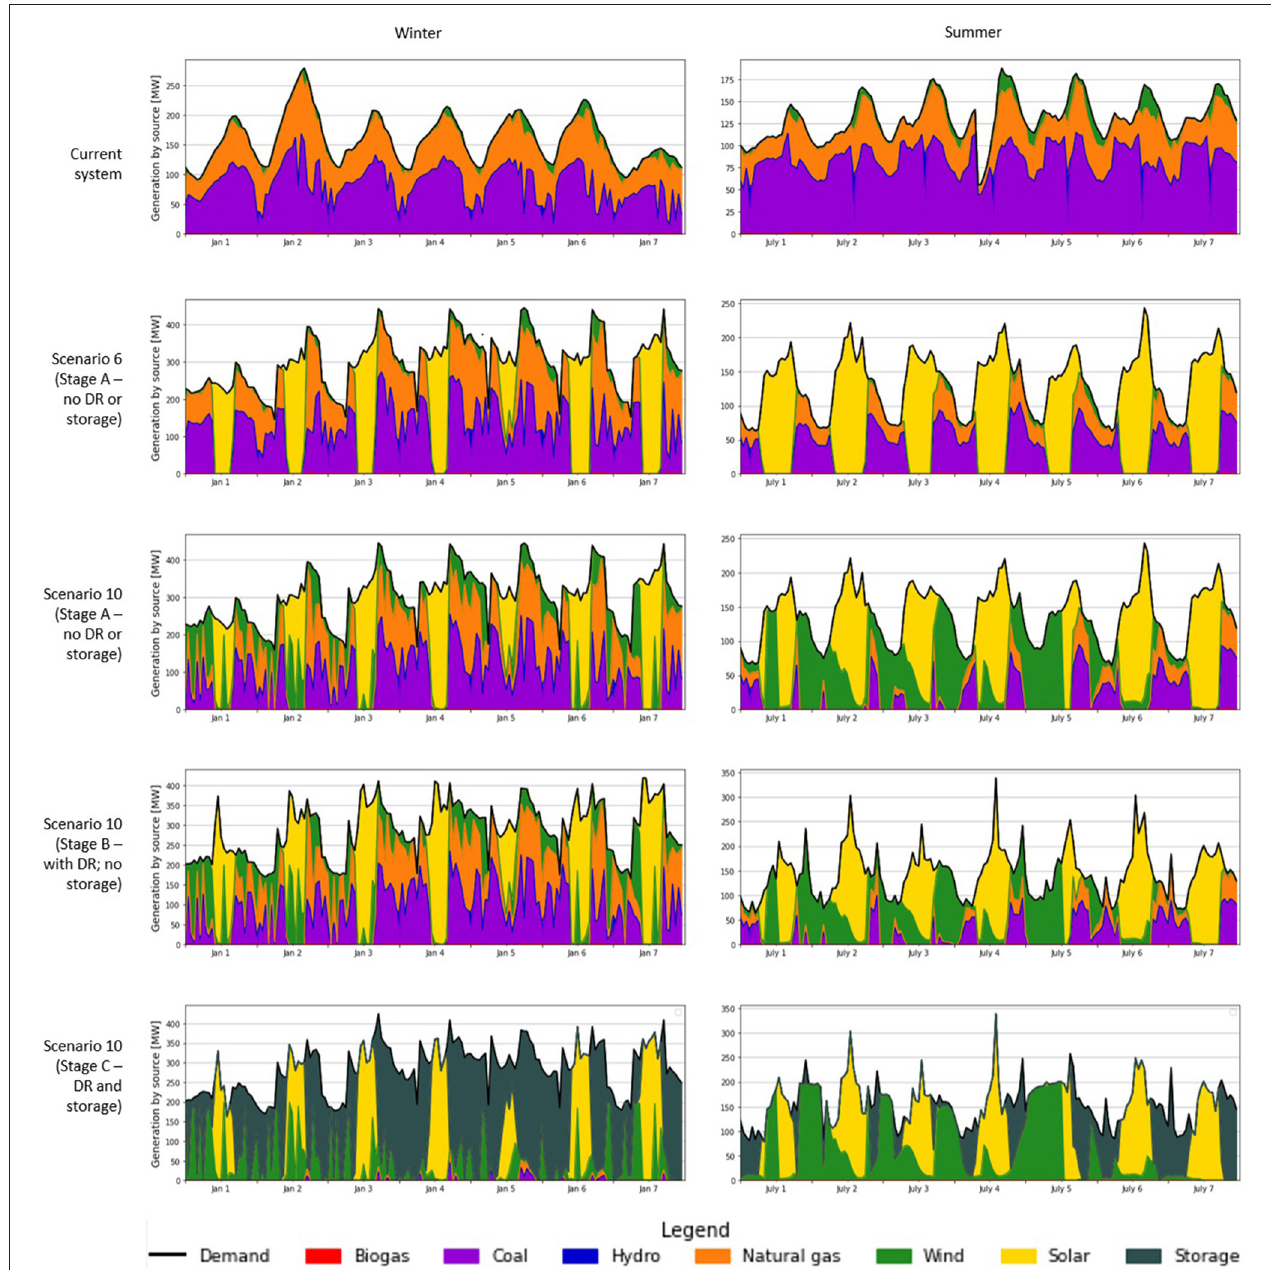
FIGURE 6 | Generation mixes of various scenarios. Winter generation is seen from January 1–7 (left column) while summer generation is seen from July 1–7 (right column). As previously outlined, Scenario 6 has added rooftop solar capacity, and Scenario 10 has added rooftop solar and wind capacity.